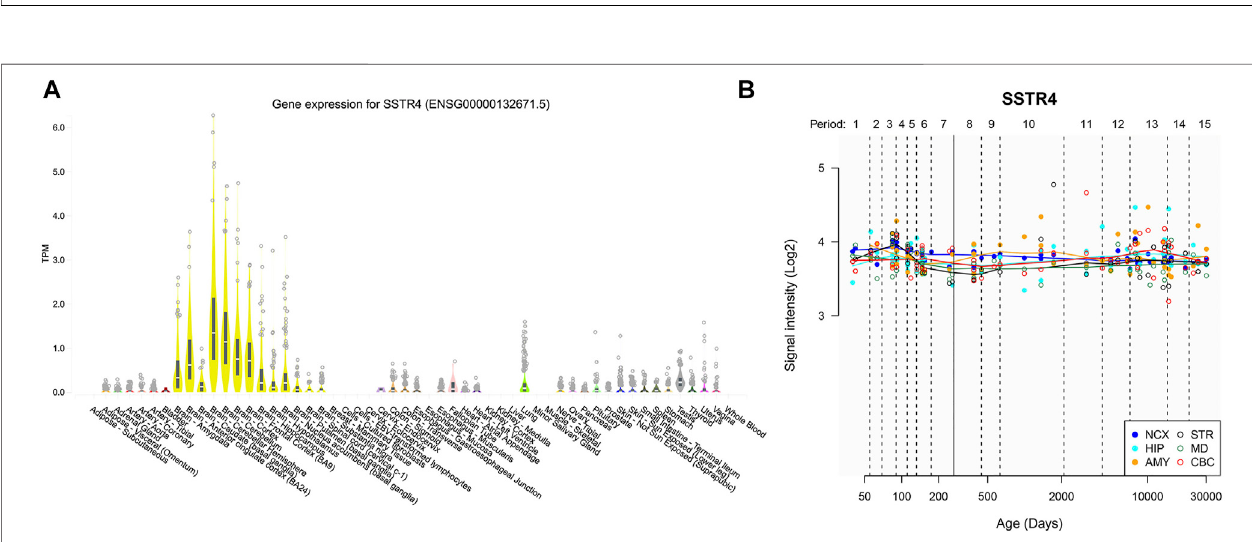
FIGURE4| Geneexpression of SSTR4 byGTExandHBT. (A) Spatialexpressionpatternofthe SSTR4 geneinhumanbrainregionsfromGTEx.TPM=transcripts perkilobasemillion.Expressionthreshold: > 0.1TPMand ≥ 6readsin20%ormoreofsamples.Boxplotsareshownasmedianand25thand75thpercentiles;pointsare displayed as outliers if they are above or below 1.5 times the interquartile ranges. Data Source: GTEx Analysis Release V8 (dbGaP Accession phs000424. v8. p2). (B) Dynamic expression pattern of the SSTR4 gene in 6 human brain regions across lifespan from HBT. NCX, neocortex; CBC, cerebellar cortex; MD, mediodorsal nucleus of the thalamus; STR, striatum; AMY, amygdal; HIP, hippocampus. Period 1, Embryonic development; Period 2, Early fetal development; Period 3, Early fetal development; Period 4, Early mid-fetal development; Period 5, Early mid-fetal development; Period 6, Late mid-fetal development; Period 7, Late fetal development; Period8,Neonatalandearlyinfancy;Period9,Lateinfancy;Period10,Earlychildhood;Period11,Middleandlatechildhood;Period12,Adolescence;Period13,Young adulthood; Period 14, Middle adulthood; Period 15, Late